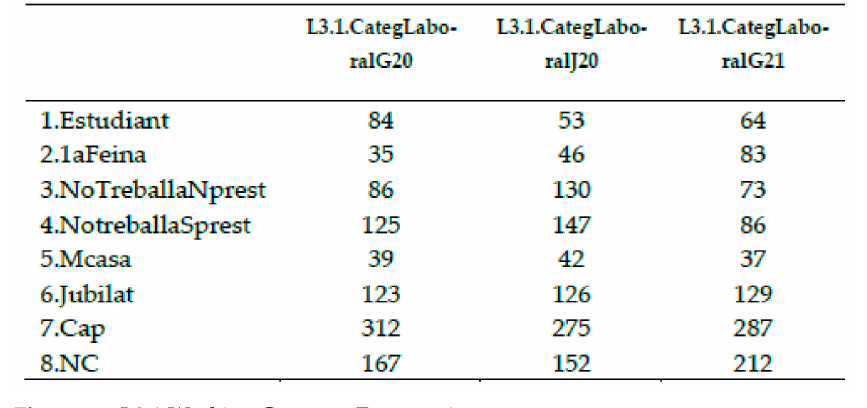
Figure 22. L3.1 Working Category Frequencies.